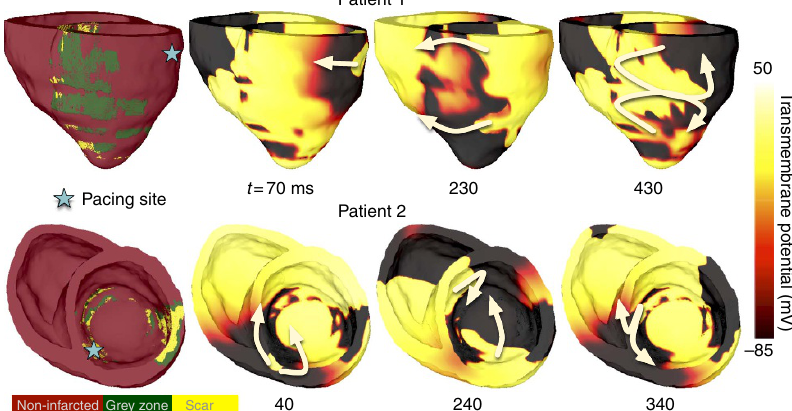
Figure 3 | Initiation of ventricular tachycardia in patients 1 and 2. Shown are patient heart geometries and transmembrane potential maps at three time points. White arrows show direction of propagation. The time instant below each map is counted from the delivery of the last pacing stimulus. In patient 1, conduction block occurs in a GZ region located in the anterior portion of the ventricles. The wavefront propagates around that GZ region and forms a figure-of-8 re-entrant circuit. In patient 2, unidirectional block occurs in GZ region located in the septum. The wavefront re-enters via an isthmus of excitable myocardium and forms a re-entrant circuit that eventually anchors to intramural scar. See Supplementary Movies 1 and 2 for corresponding movies of the VT initiation and resulting